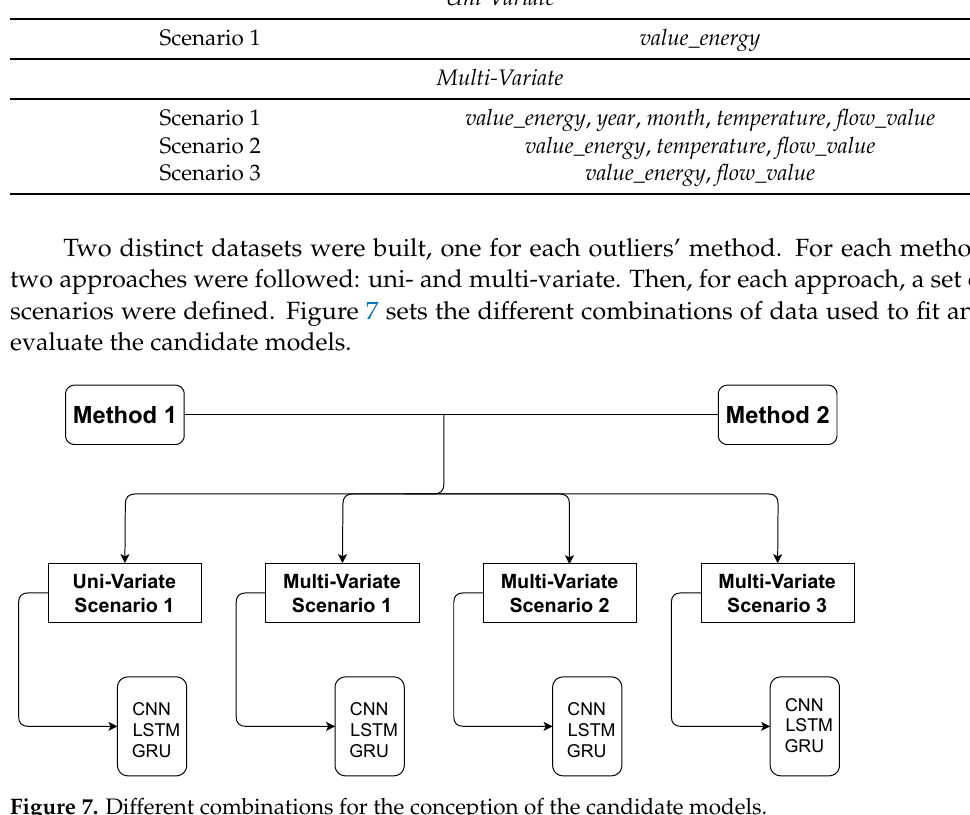
Figure 7. Different combinations for the conception of the candidate